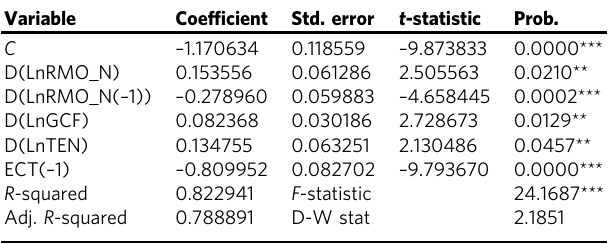
Note: *** and ** indicate signi fi cance at 1% & 5% levels,